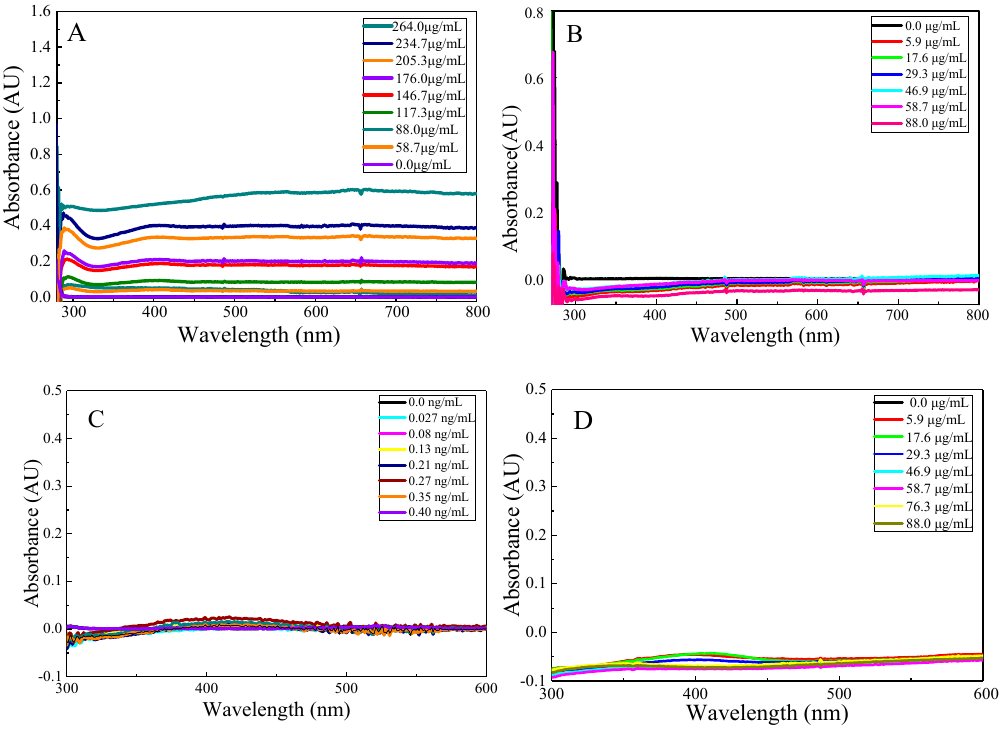
Figure 3. Spectral Characterization. ( A ) UV-Vis absorption spectra of AgCOF at high concentration: (0, 58.7, 88.0, 117.3, 146.7, 176.0, 205.3, 34.7, 264.0) μ g/mL AgCOF. ( B ) UV-Vis absorption spectra of AgCOF at low concentration: (0, 5.9, 17.6, 29.3, 46.9, 58.7, 88.0) μ g/mL AgCOF. ( C ) UV-Vis absorption spectra of NaBH 4 -AgNO 3 -TC system: (0, 0.027, 0.08, 0.13, 0.21, 0.27, 0.35, 0.4) ng/mL NaBH 4 + 0.87 mmol/L AgNO 3 + 6.67 mmol/L TC. ( D ) UV-Vis absorption spectra of AgCOF-AgNO 3 system: (0, 5.9, 17.6, 29.3, 46.9, 58.7, 76.3, 88.0) μ g/mL AgCOF + AgNO 3 , 85 °C.